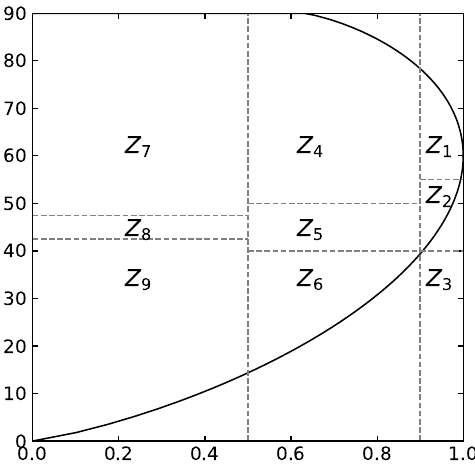
Figure 4. H / α classification hyperplane.